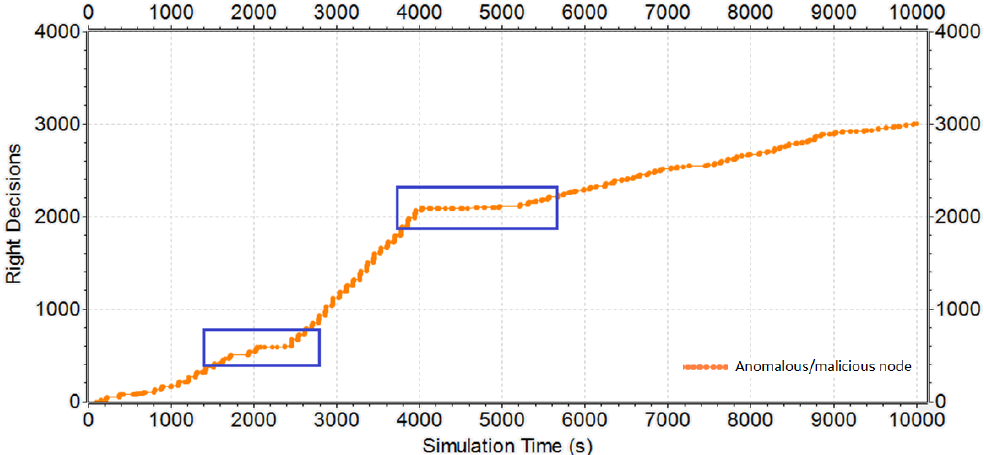
Figure 18. Evolution of right decisions.